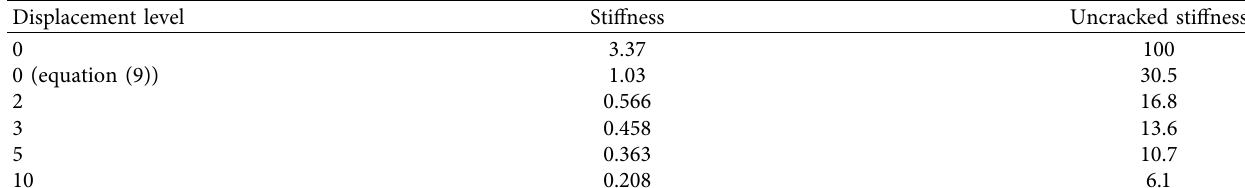
Figure 18: Parabolas in a hysteresis loop. Table 3: Stifness at zero displacement.